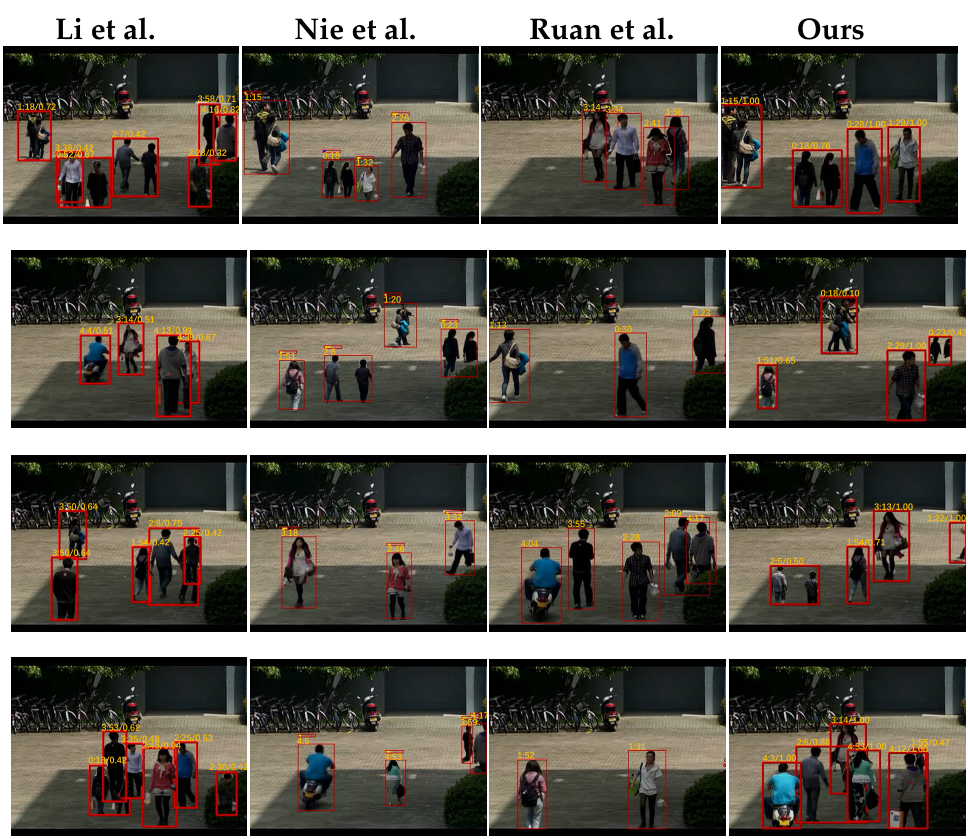
Figure 6. Frames from the synopsis videos that were generated by using different methods on Video 1